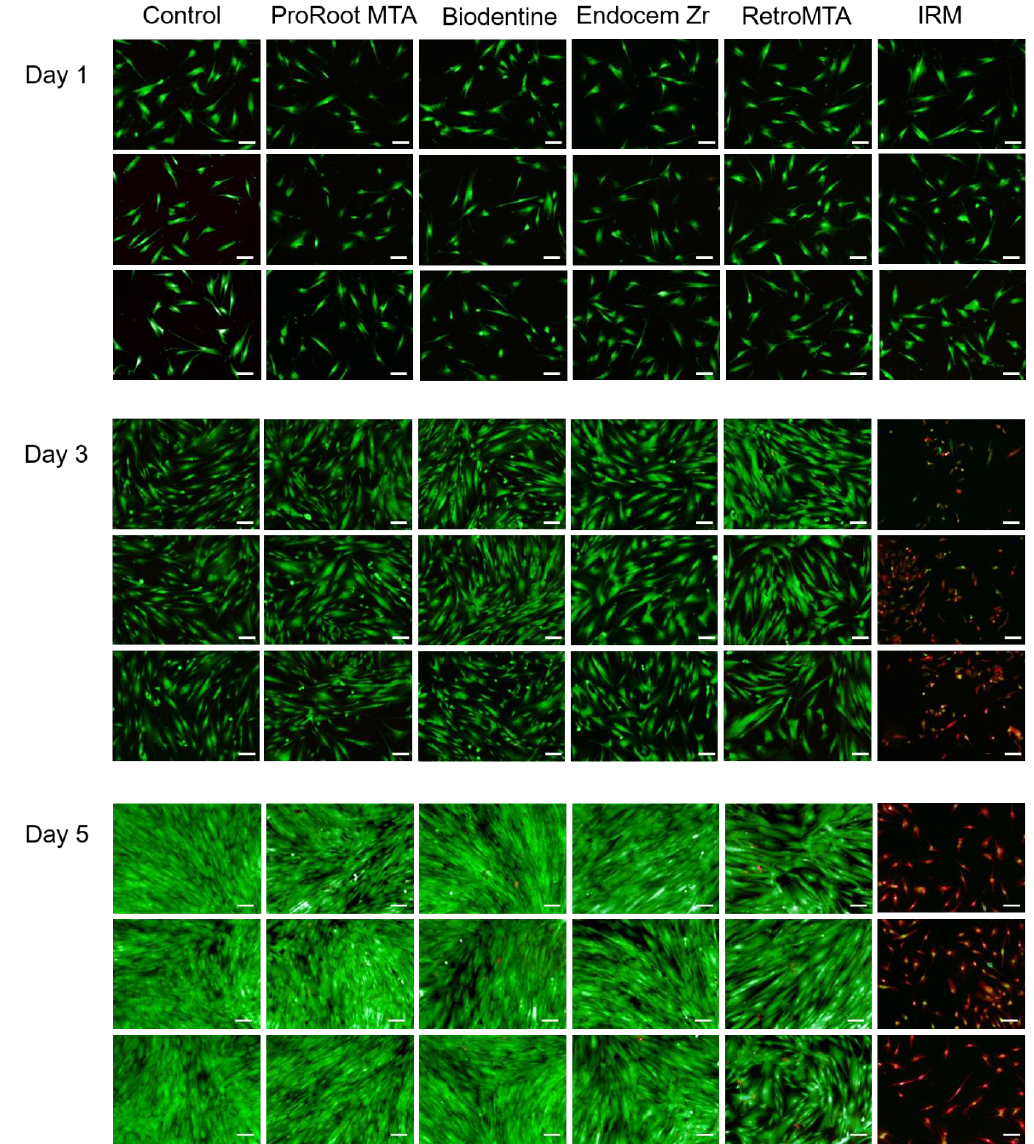
Figure 4. Results of live/dead staining assay of all tested calcium silicate-based cements (scale bar = 200